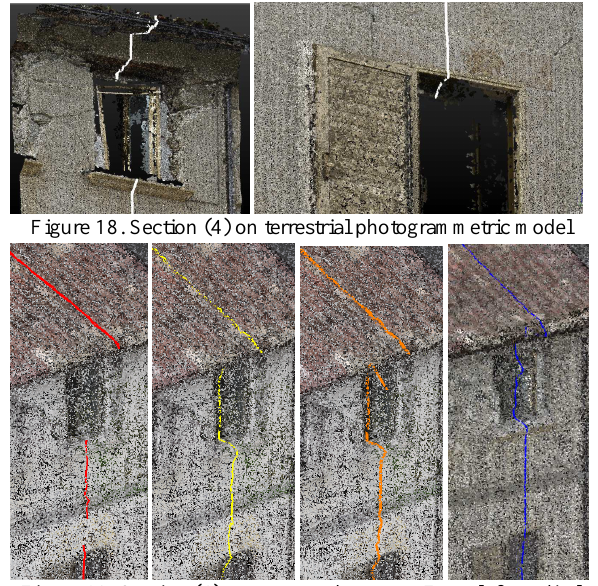
Figure 19. Section (4) on a zoomed excerpt. From left: nadiral cameras; Oblique cameras, aerial model, HQ data fusion